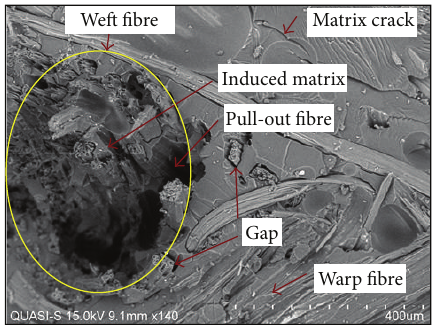
Figure 14: SEM analysis on woven kenaf composites.